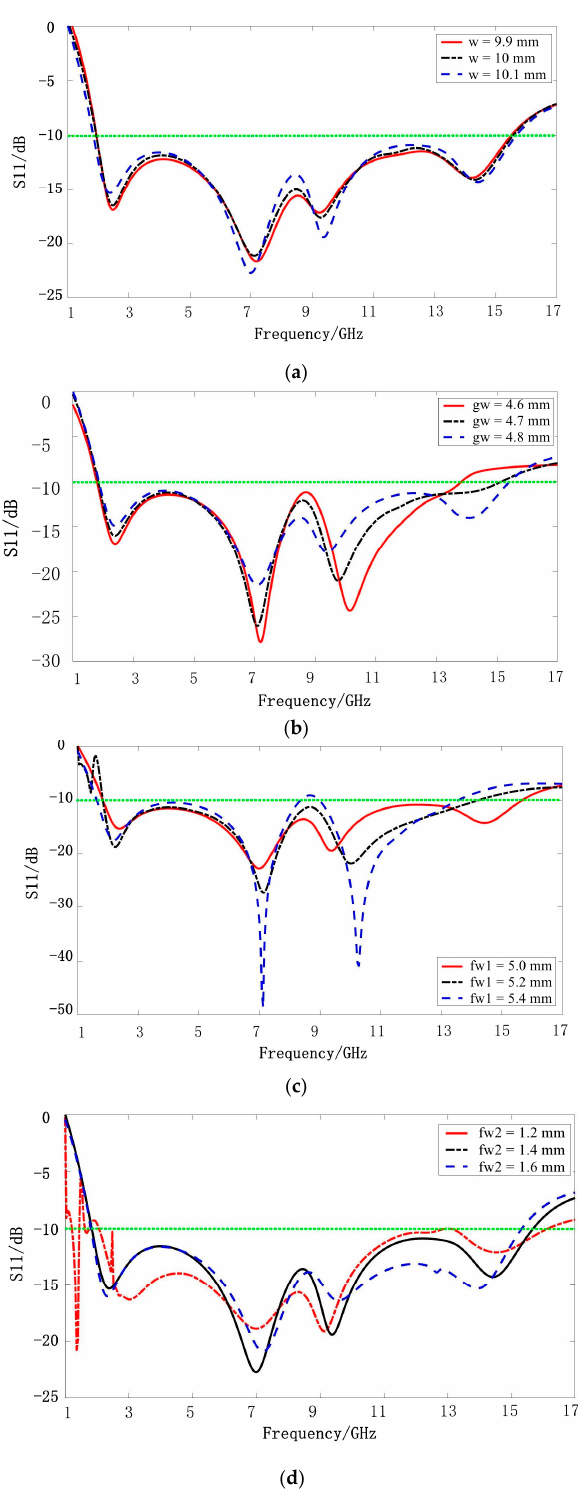
Figure 5. The variation curve of the reflection coefficient of UWB antenna with ( a ) w, ( b ) fw1, ( c ) fw2, ( d ) gw.